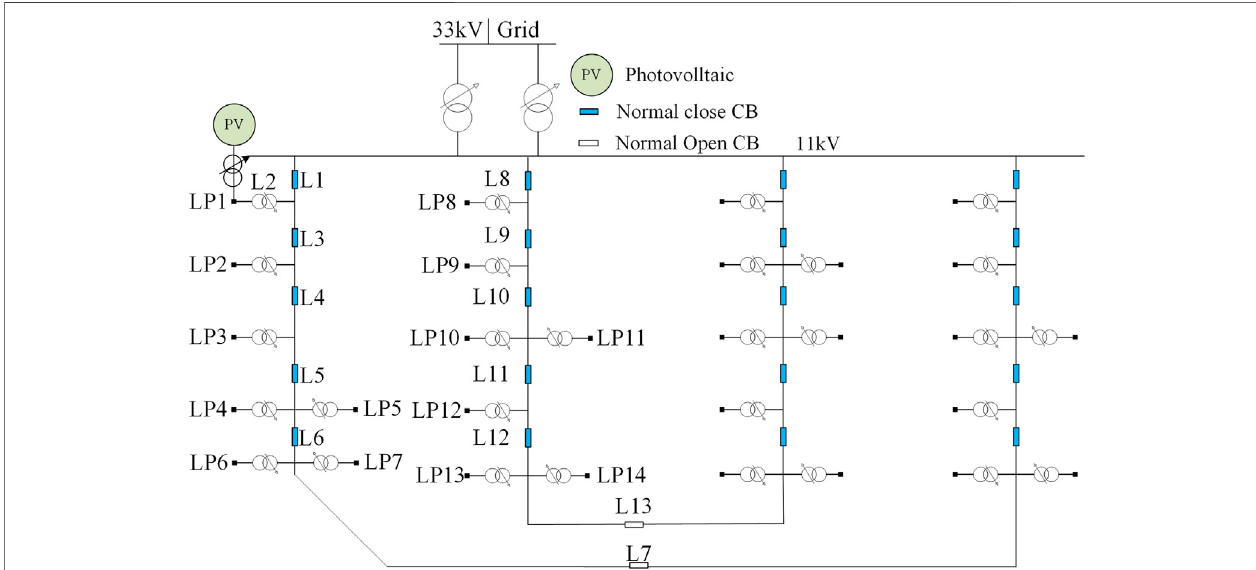
FIGURE 2 | Diagram of the